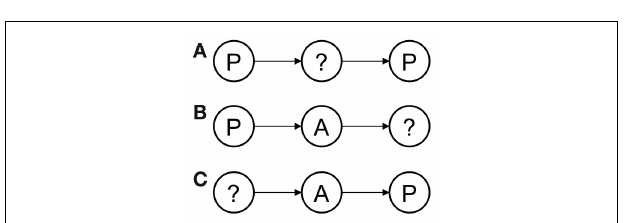
FIGURE 9 | The network model of joint episodic-procedural memory facilitates prospection in three senses: (A) prospection by predicting the outcome of an action carried out in given perceptual circumstances, (B) prospection by predicting the action required to achieve a goal in given perceptual circumstances, and (C) abductive inference of the perceptual states that explains an outcome of a give action